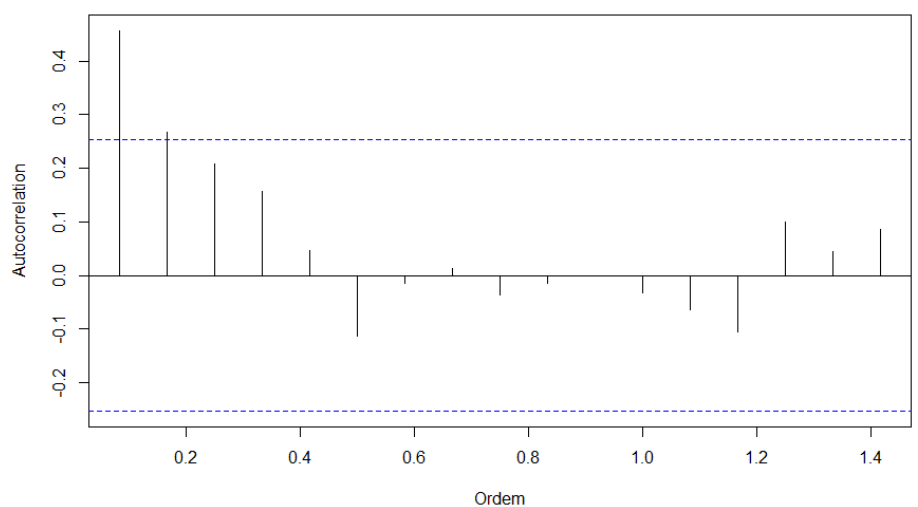
Figure 6. Correlogram of the potato production time series with normalized data. In Figure 6, the vertical axis indicates autocorrelation, and the horizontal axis indicates lag. The blue dashed line indicates where it is significantly different from zero. Note that all values except the first are within the blue dashed line limit. This means zero autocorrelation, indicating that potato production can be random and supposedly stationary. On the other hand, if the values were above the dashed line, the series would not be random and would